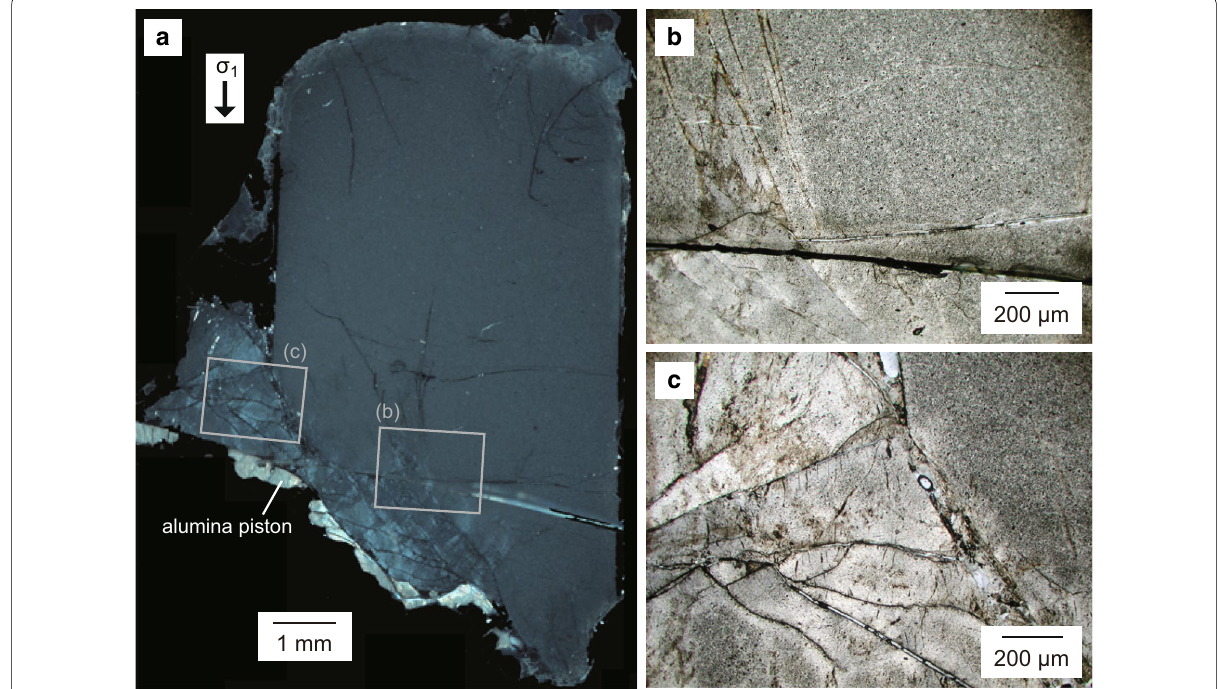
Fig. 4 Optical image of the deformed dry sample. a Image of the entire sample (cross‑polarized light). The compression direction ( σ 1 ) is shown by an arrow. Cataclastic flow is localized, especially at the bottom of the sample. Rectangles denote the locations for enlarged images ( b ) and ( c ). b Fractured area (plane‑polarized light). c Strain‑localized areas (plane‑polarized